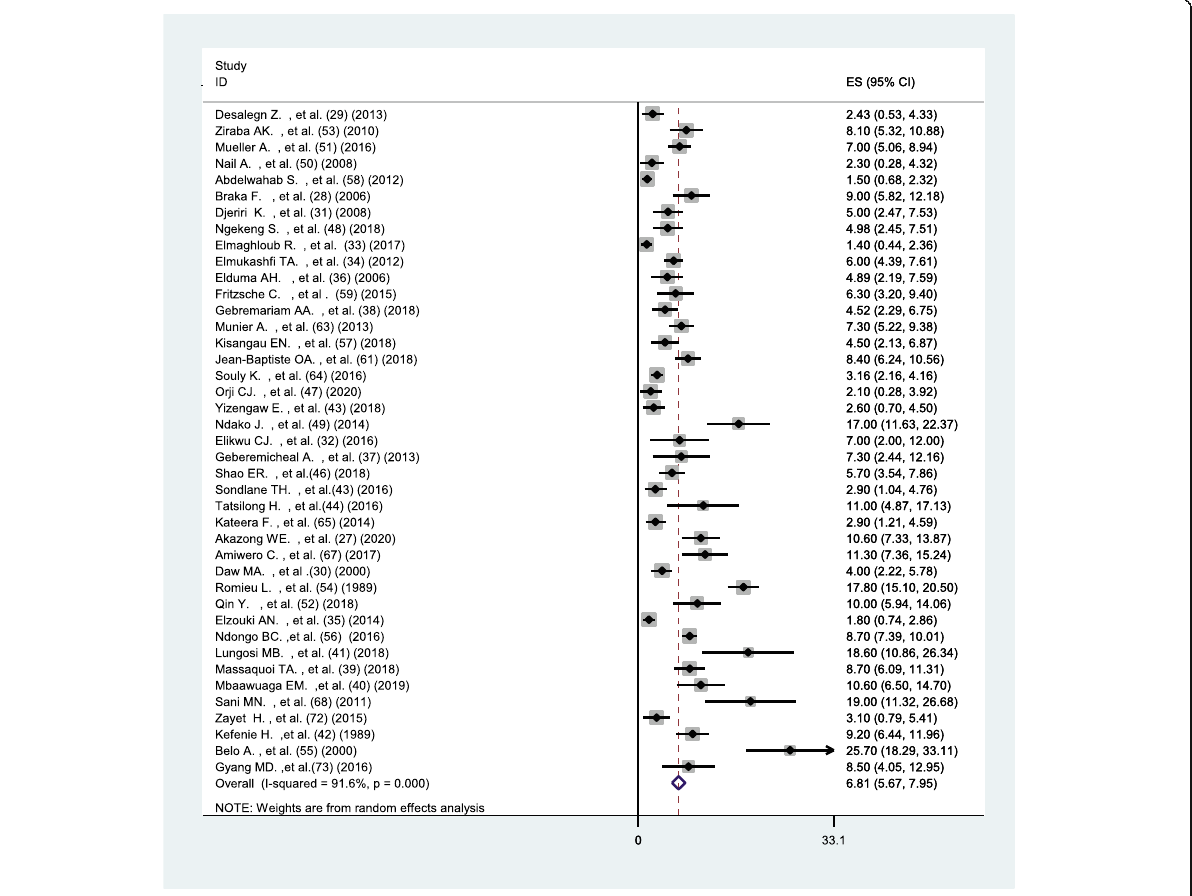
Fig. 2 Forest plot showing the pooled prevalence of hepatitis B among HCWs in